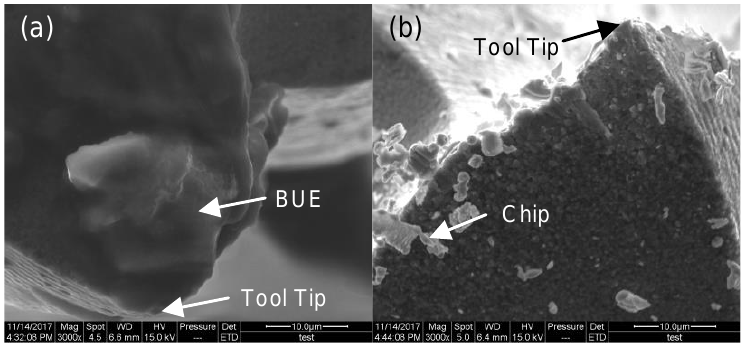
Figure 6. Scanning Electron Microscope (SEM) image of tool surfaces. ( a ) In the dry micromilling case; ( b ) in the MQCL micromilling case.